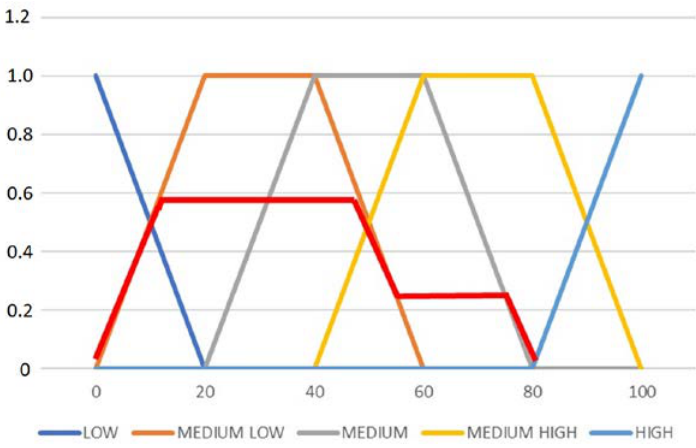
Figure 19. Aggregation of rules for assessment of design for manufacturing organization 19